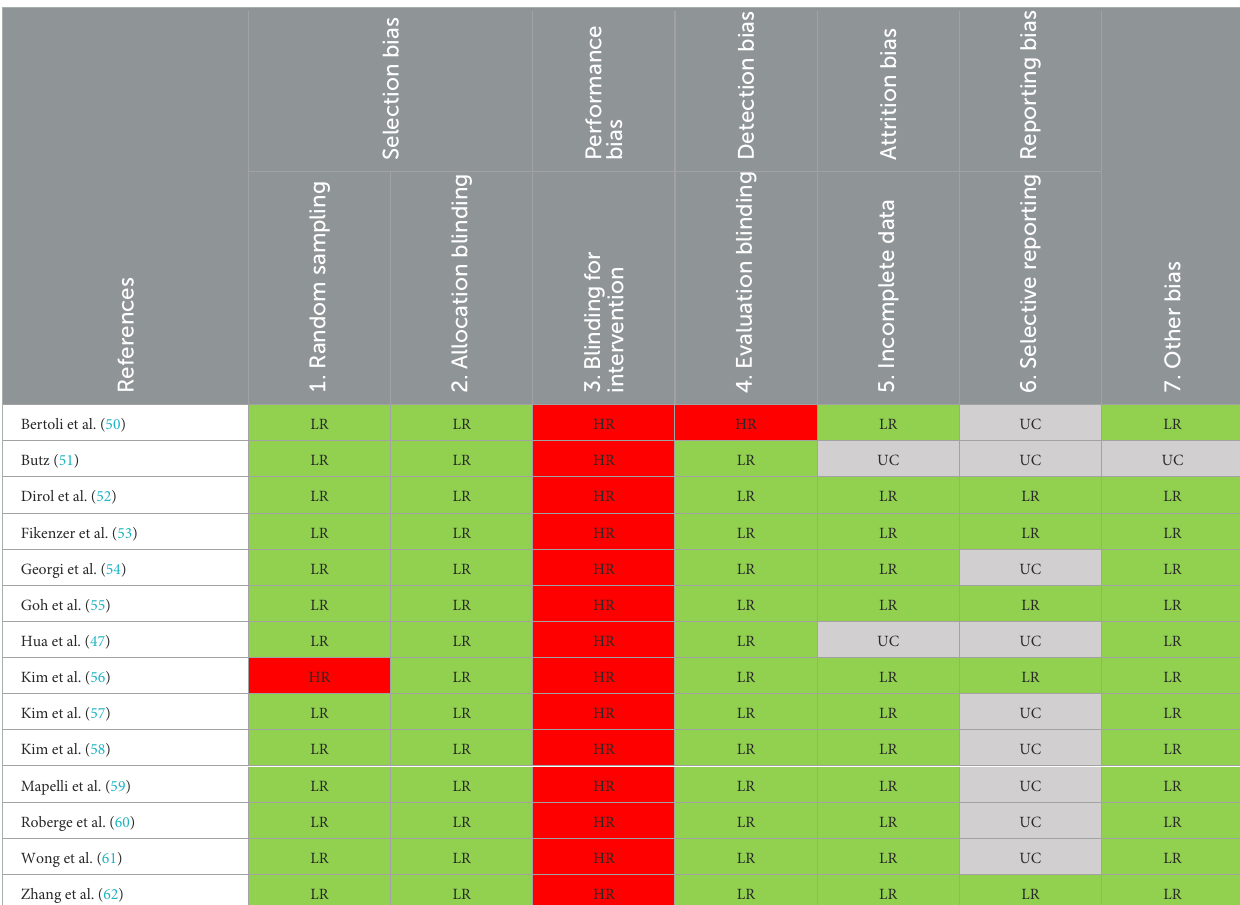
TABLE 2A Quality appraisal of randomized trials (Cochrane RoB tool ++ ).